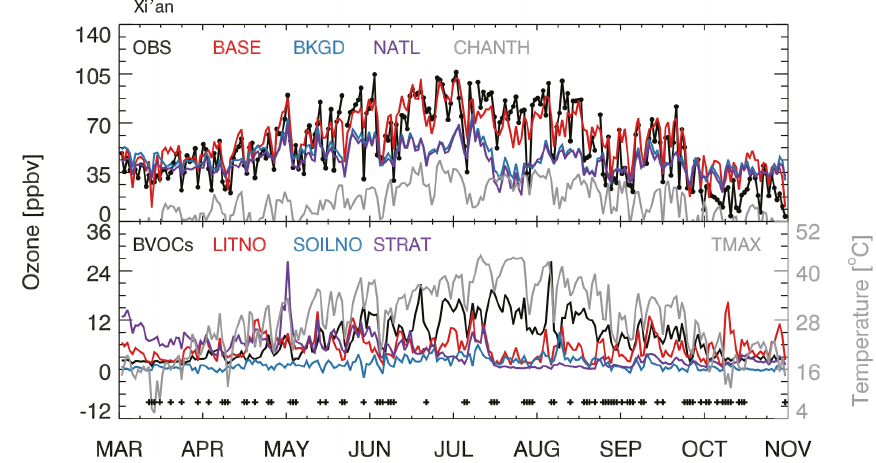
Figure 9. Same as Fig. 7 but for Xi’an.